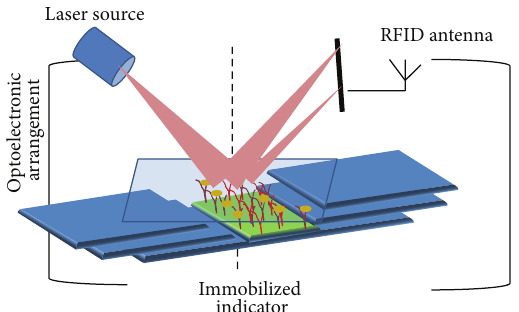
Figure 3: Architecture of an optical biosensor. Reproduced from Dey and Goswami